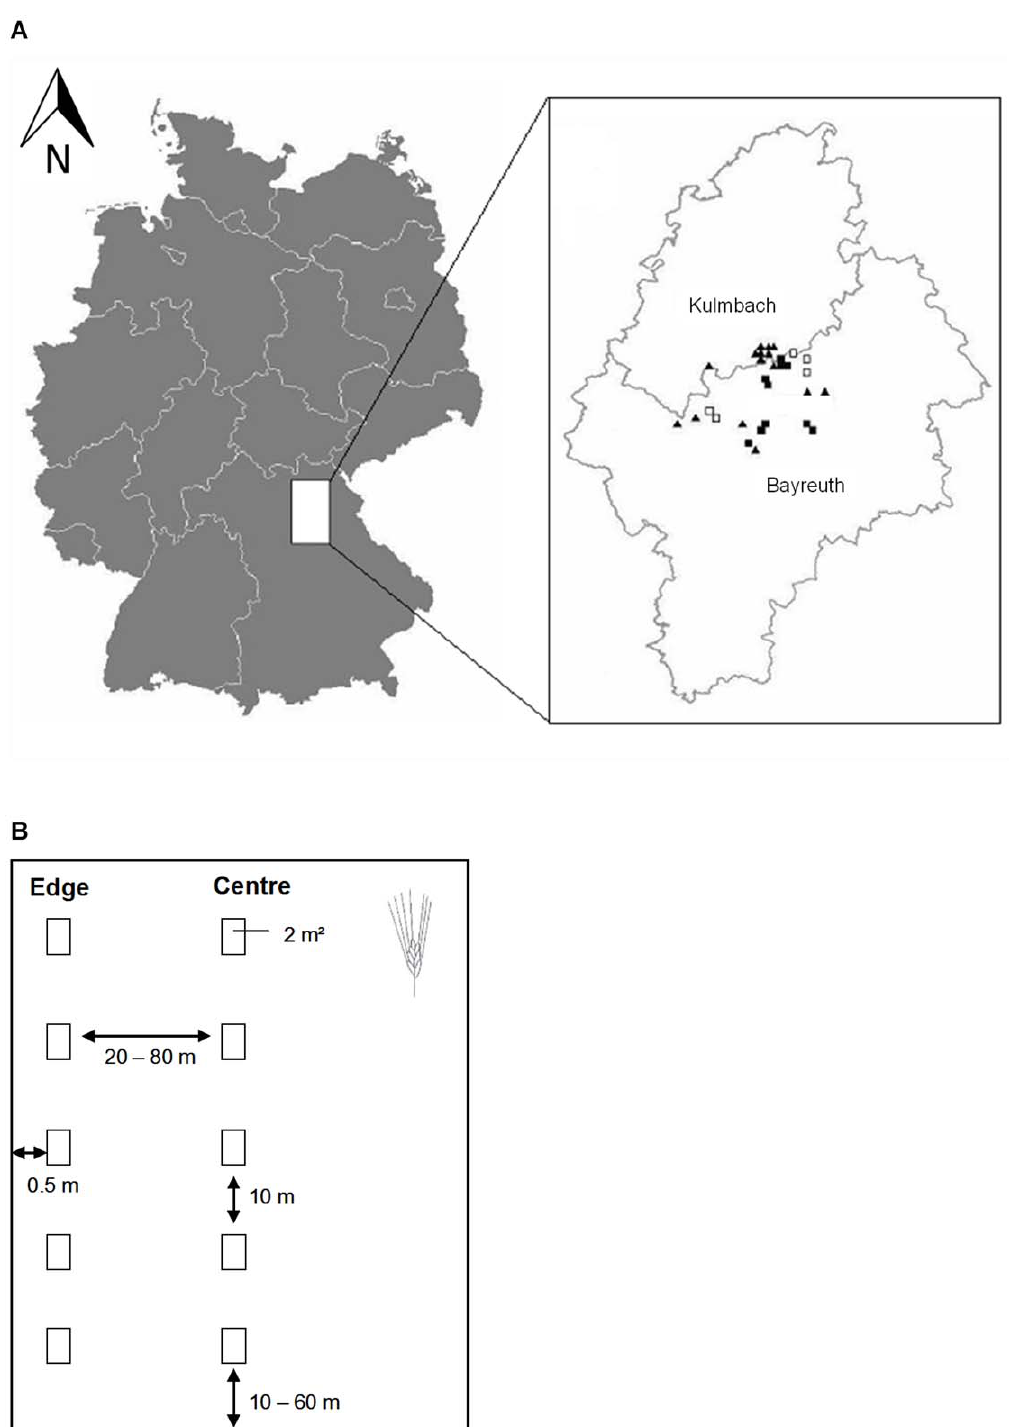
Figure 1. Location of study region in southern Germany and used sampling scheme. (a) The 30 triticale fields were located in the northern part of Bavaria in the districts of Bayreuth and Kulmbach (Symbols: & conventional, not treated; % conventional treated with insecticides; m organic farming system). (b) Sampling scheme in each triticale field. Five study plots were surveyed at the edge and five in the centre of each field.